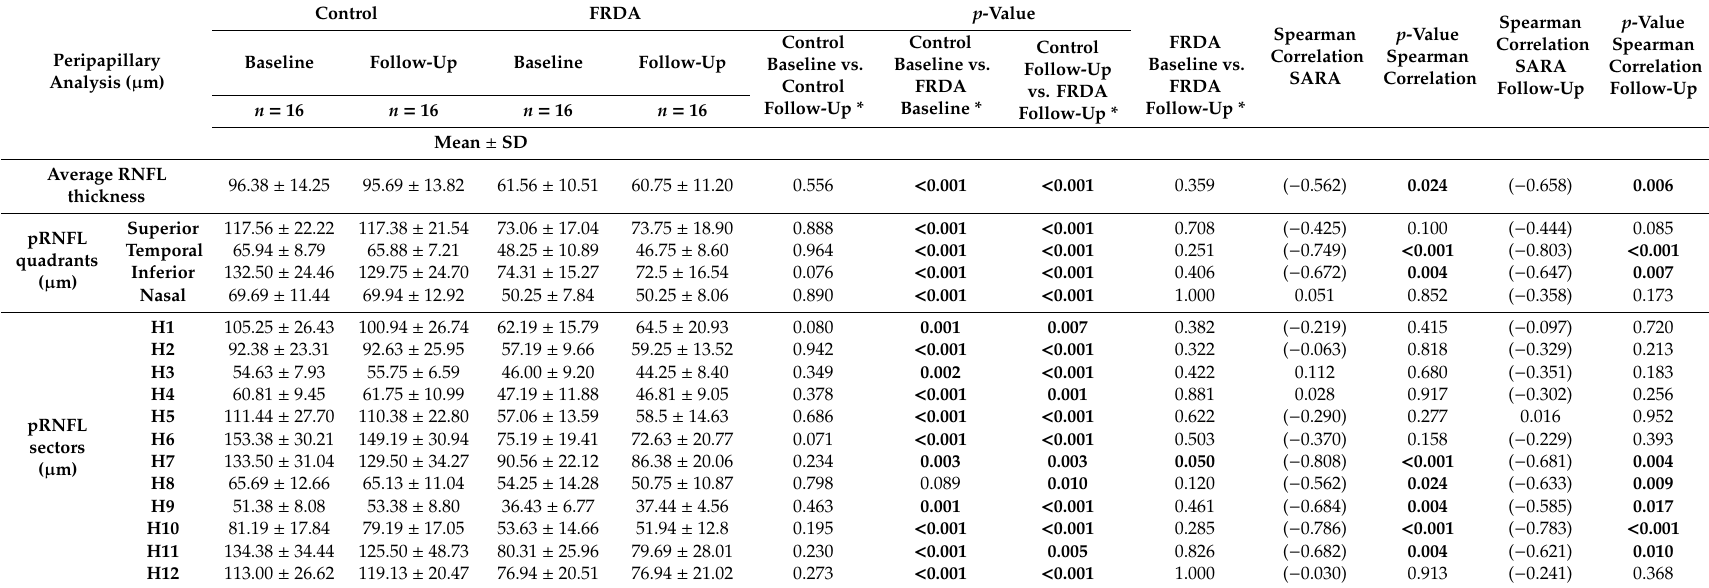
Table 2. Analysis of peripapillary RNFL measures by OCT between FRDA and control